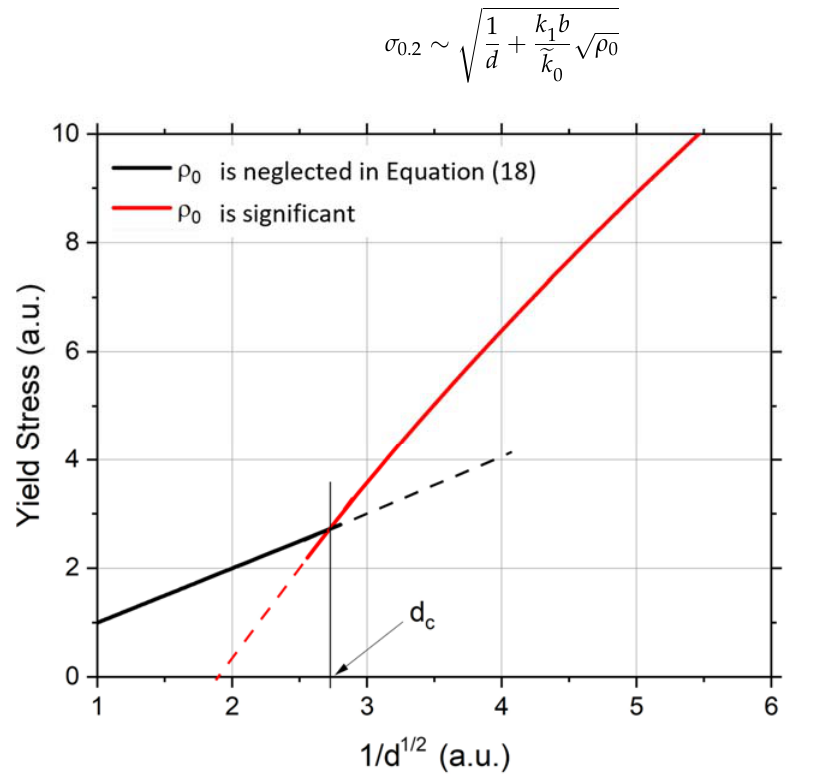
Figure 3. Schematic illustration of the two-stage Hall–Petch behavior that has been frequently reported for pure metals and alloys